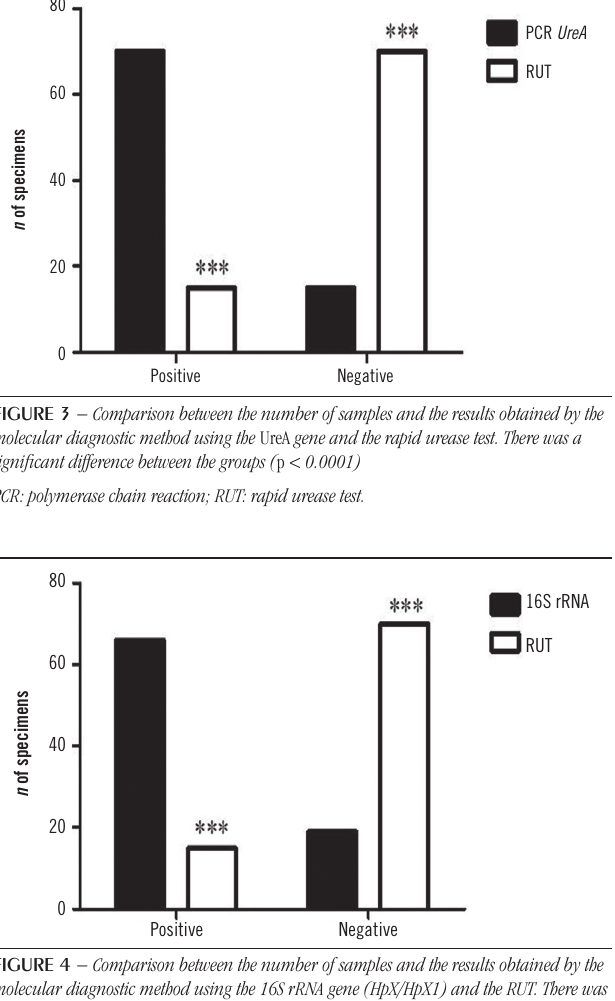
A comparison between the results from molecular diagnosis using both genes did not show a statistically significant difference ( p < 0.5656) (“Data not shown”).